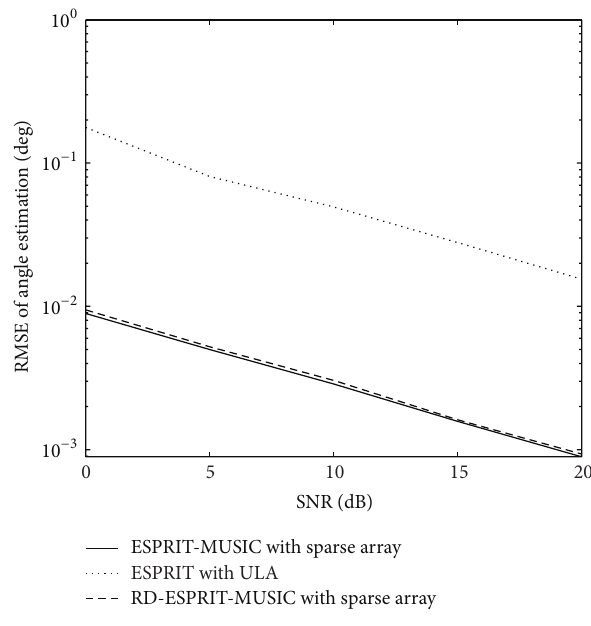
Figure 5: RMSE of angle estimation of the first target with different 𝐿 . Figure 6: Angle estimation performance comparison.